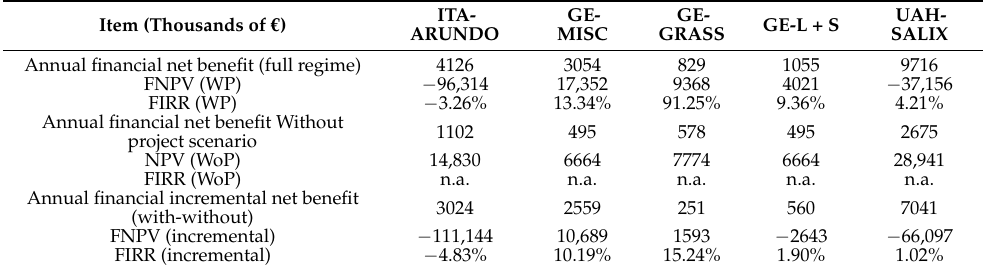
Table 5. With Project (WP), Without Project (WoP), and incremental financial FNPV and FIRR results.